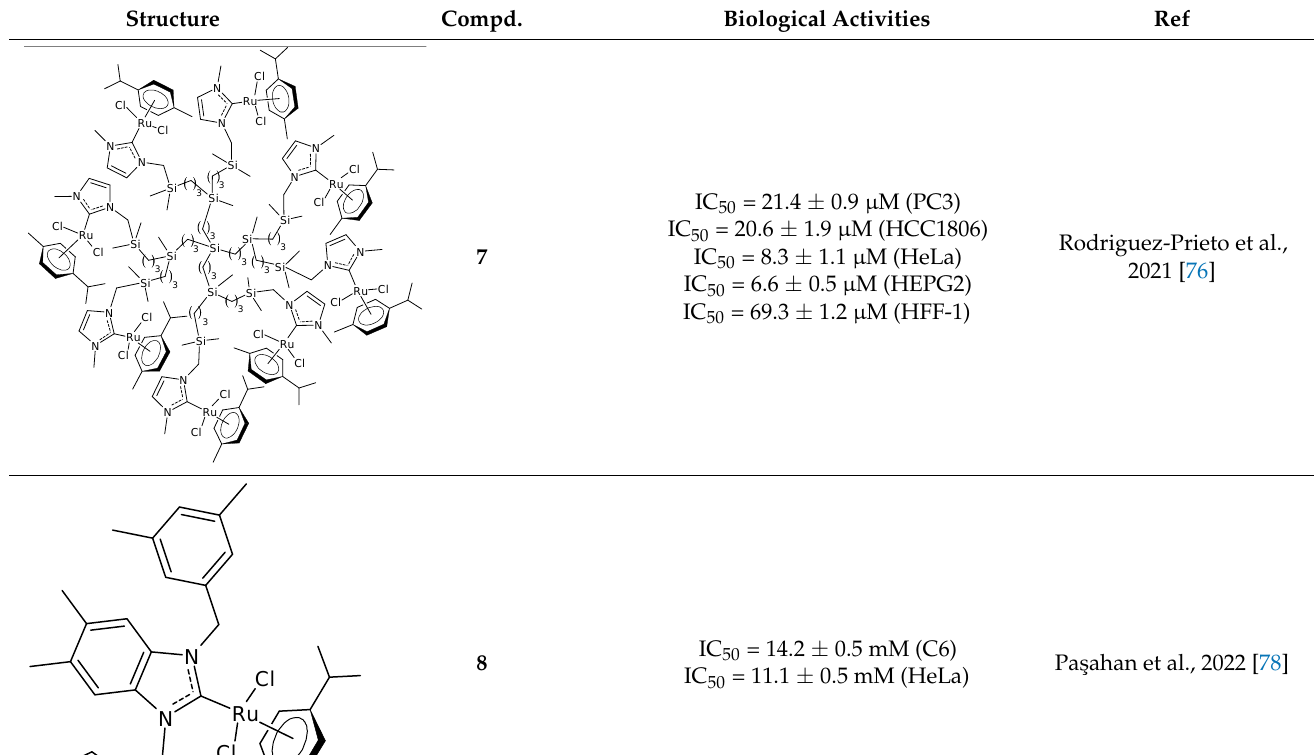
Table 1. Cont. Structure